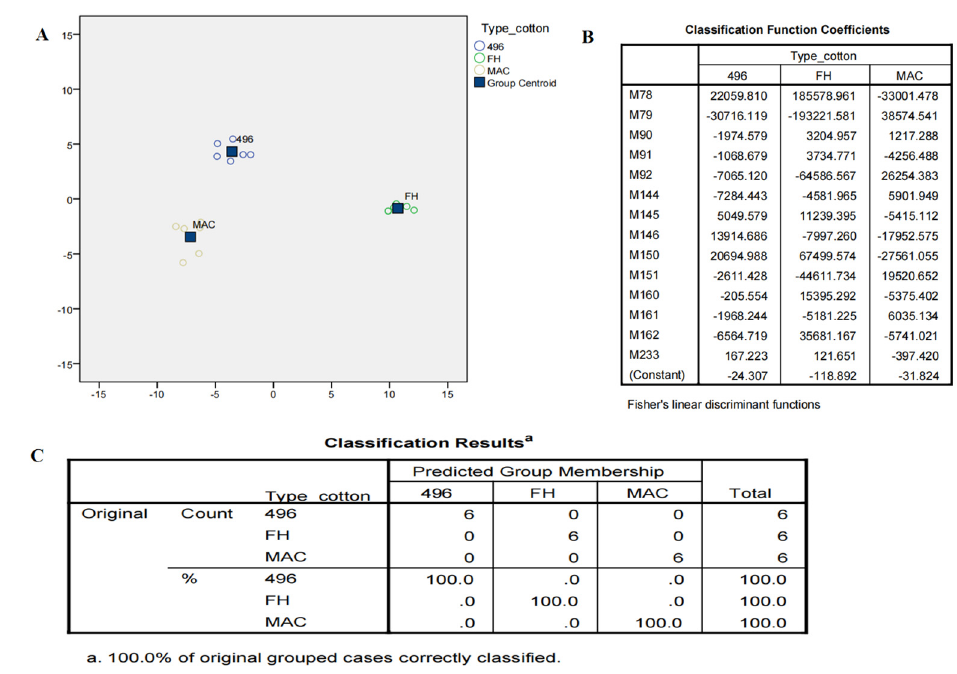
Molecules 2023 , 28 , x FOR PEER REVIEW Figure 5. ( A ) Canonical score plot of discriminant analysis showing maximum variance in three varieties of cotton. ( B ) Fisher’s discriminant functions from LDA. M78, M79 are nonanoic acid; M90–M92 are valine; M144–M146 refer to alanine; M150–M151 refer to citrulline; M160–M162 refer to arginine; M233 is malic acid. ( C ) Classification model of the different cotton varieties.